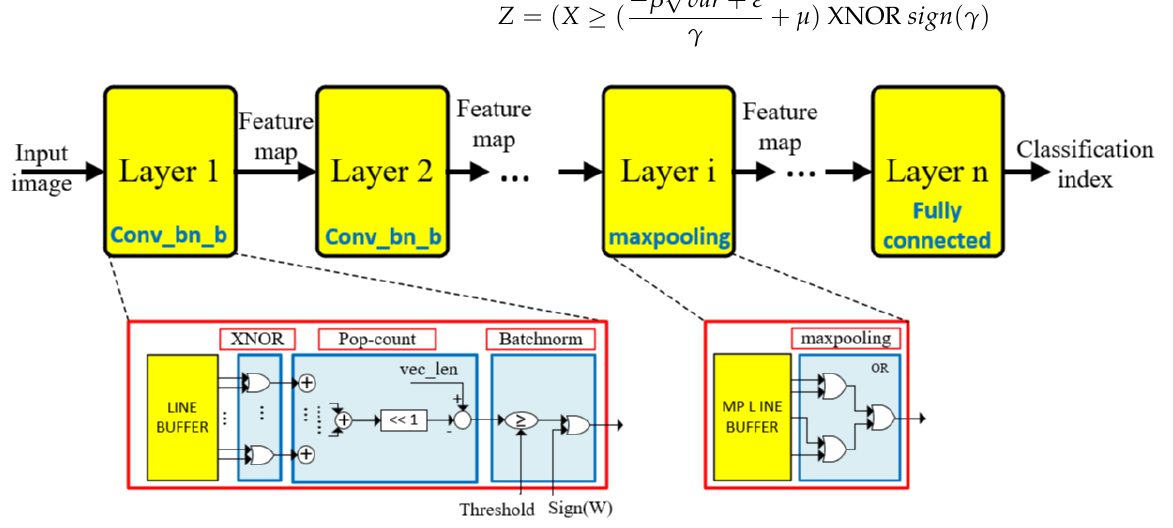
Figure 4. Binarized Neural Network hardware architecture on